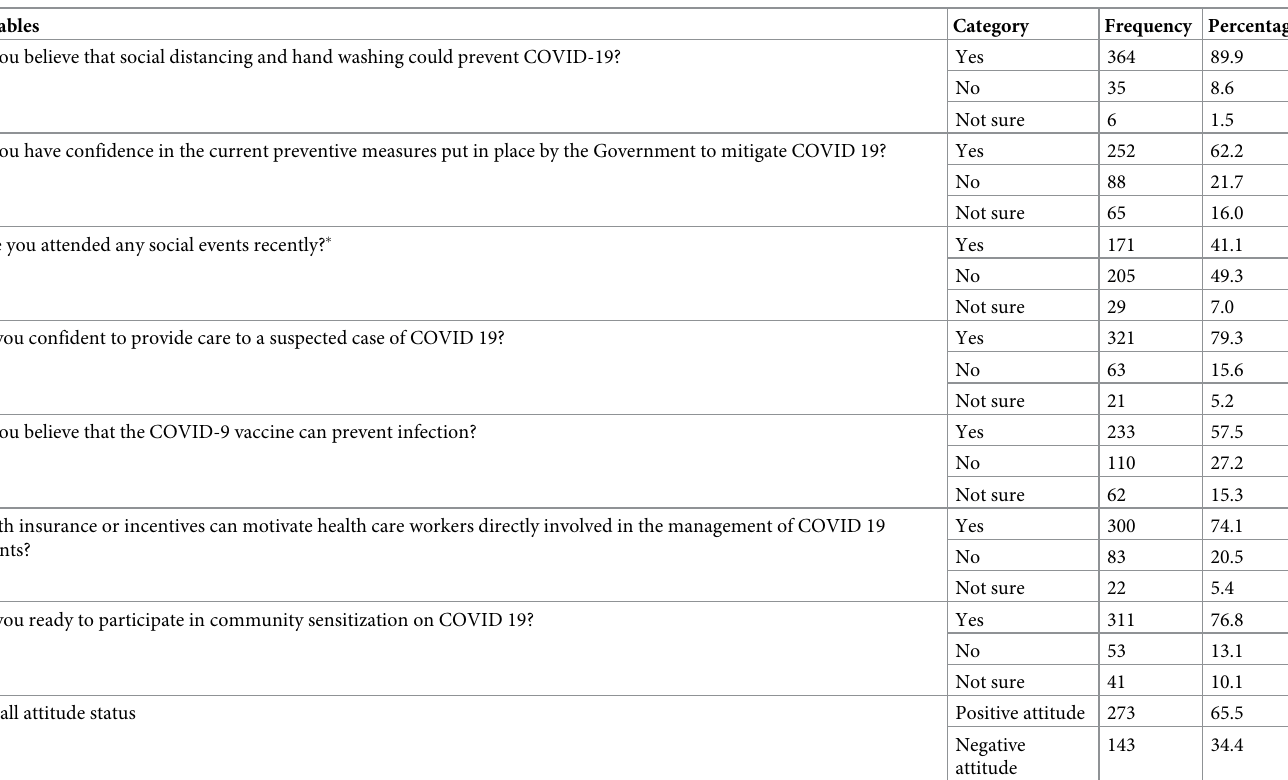
Table 4. Attitude towards COVID-19 prevention among HCWs working at hospitals of southwestern Ethiopia, 2021 (n = 405). Variables